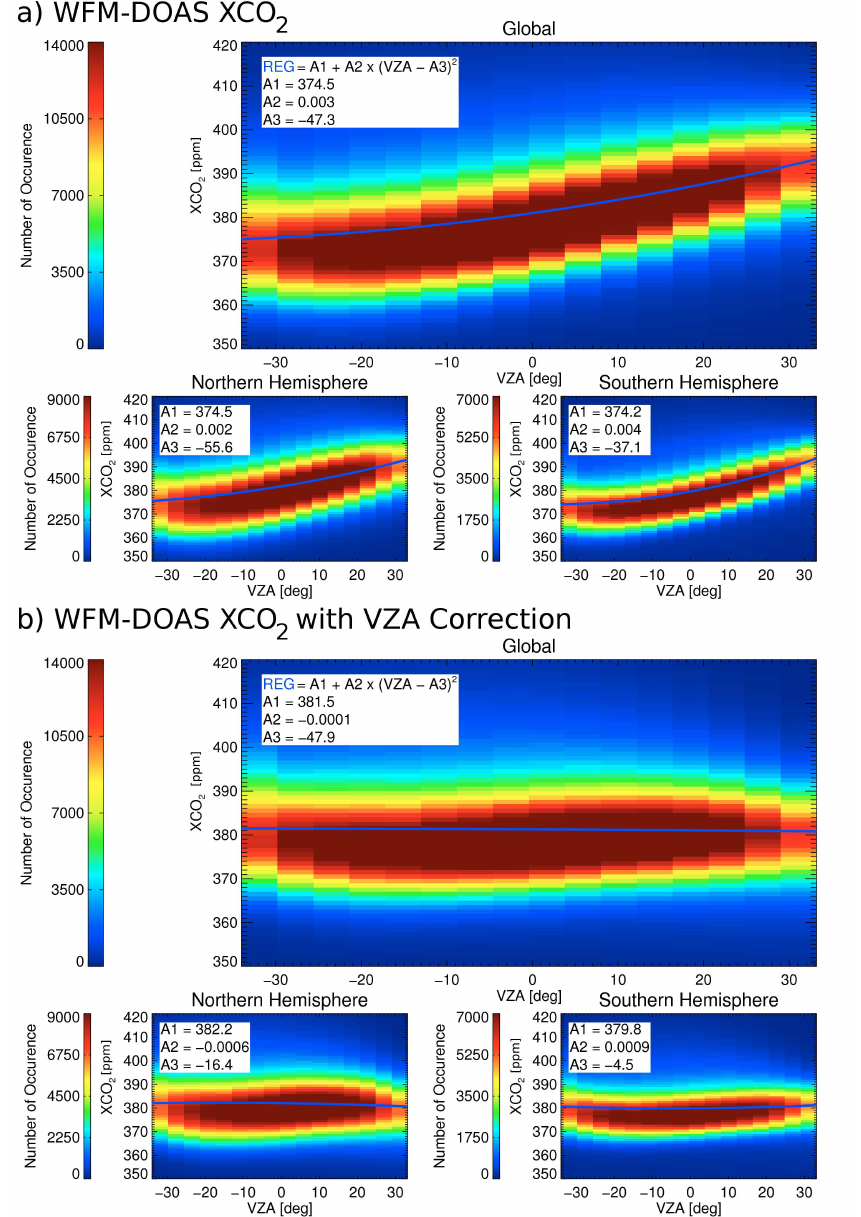
Fig. 7. WFM-DOAS XCO 2 v2.1 VZA dependency before (a) and after (b) the scan-angle-bias correction. (a) 2-D-histogram of WFMDv2.1 XCO 2 versus the VZA using all data between 2003 and 2009. The blue curve is a quadratic fit with fit parameters A 1 (in ppm), A 2 (in ppmdeg − 2 ) and A 3 (in deg). (b) As (a) but after the bias correction.